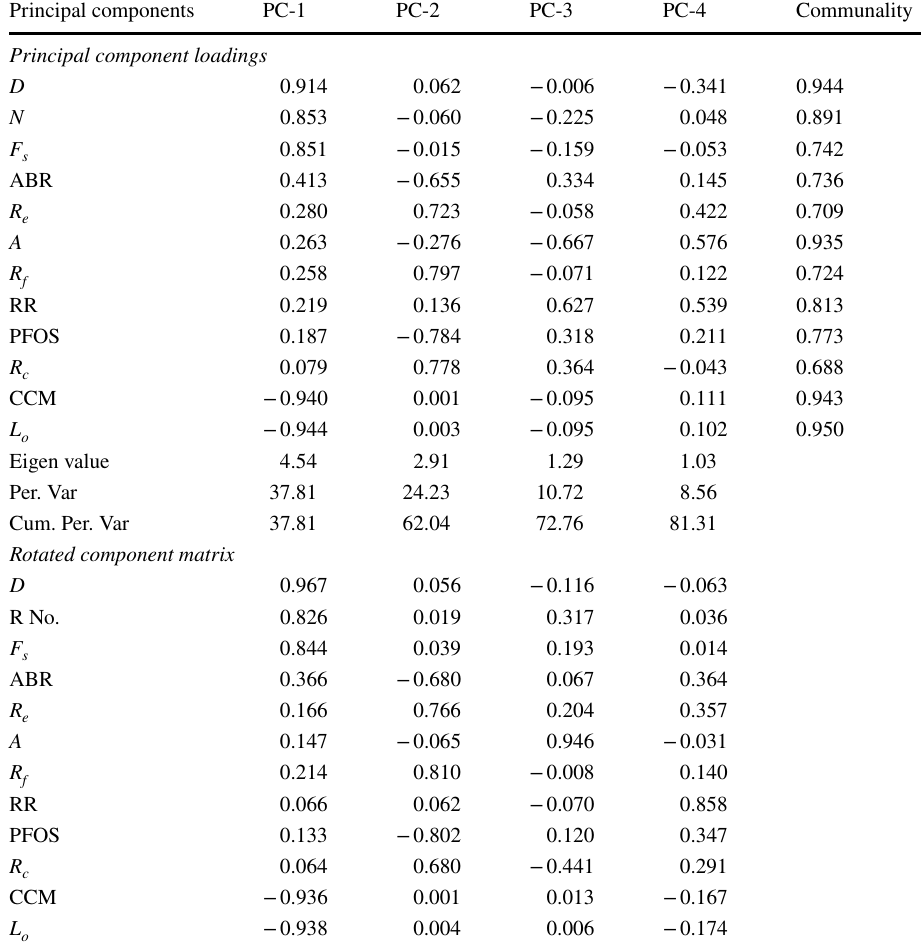
Table 5 Factor analysis for the linear, aerial and relief aspects of drainage morphometric